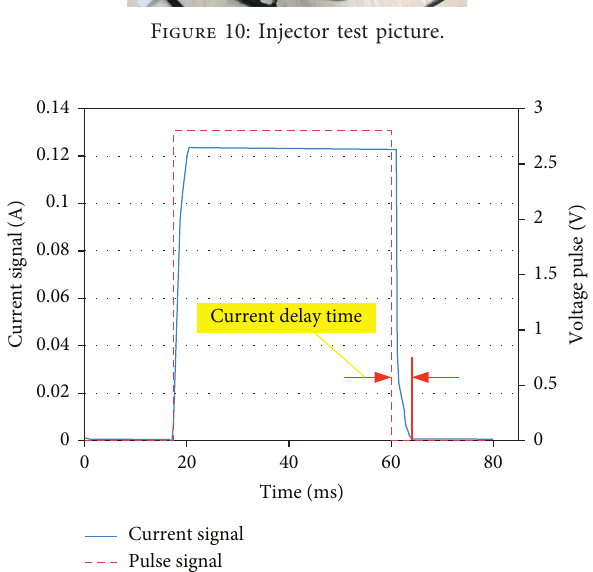
Figure 11: Results of the current delay time test.